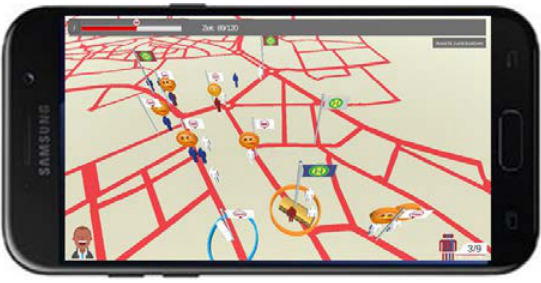
Figure 3. Screenshot of a game situation in level 5 of the B.u.S.